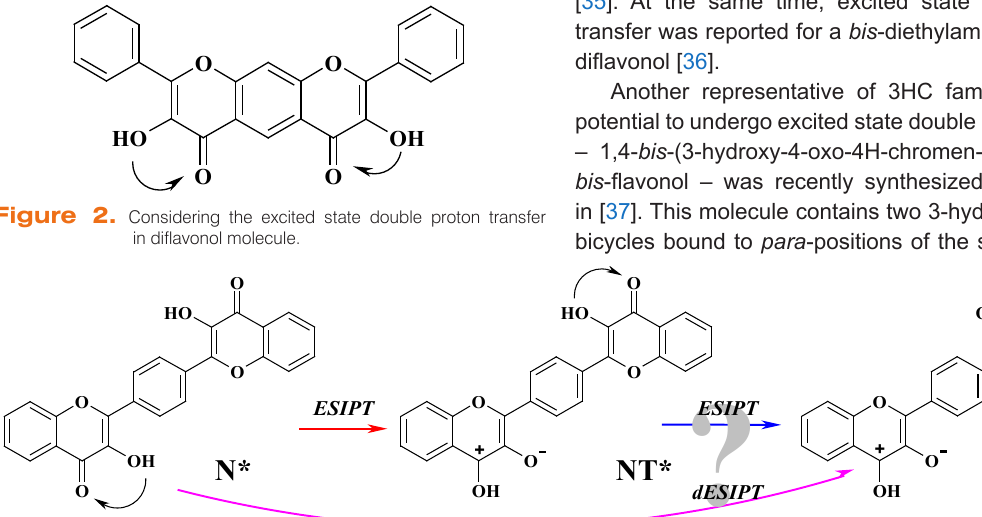
Figure 3. Possible excited state single and double proton transfer in the bis -flavonol